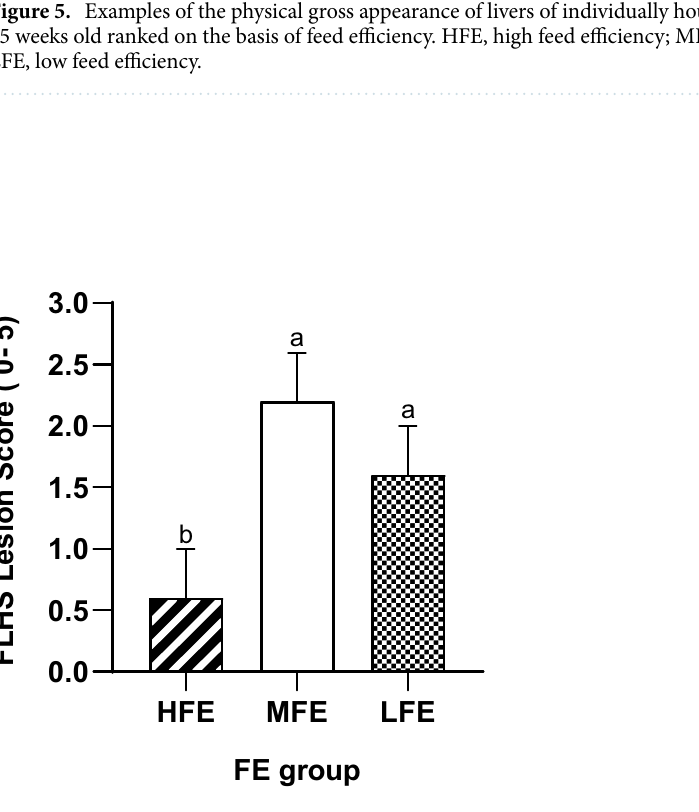
Figure 6. The effect of feed efficiency on FLHS lesions score as seen at necropsy of individually housed ISA Brown hens aged 45 weeks old of varying feed efficiencies ( n = 30, 10 per FE group). Livers were scored on a scale of 0–5 where higher value indicates greater severity. FE, feed efficiency; FLHS, fatty liver haemorrhagic syndrome; HFE, high feed efficiency; MFE, medium feed efficiency; LFE, low feed efficiency; SEM, standard error of mean; abc Means within rows not sharing a common suffix are significantly different at the 5% level of